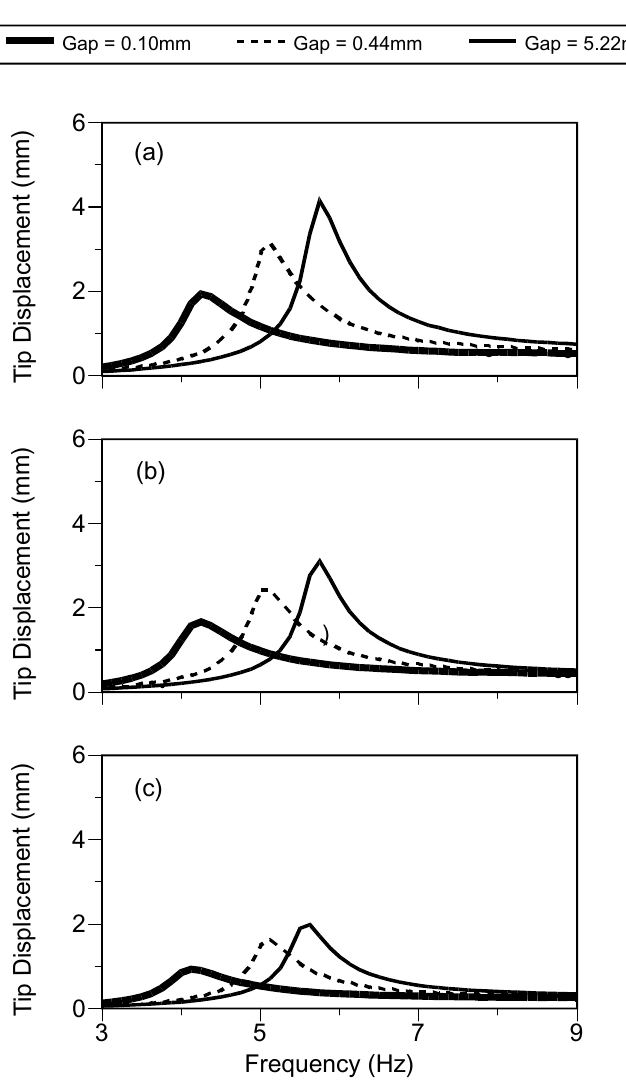
Fig. 9. Frequency response of beam tip at different gaps with base magnets and ferromagnetic constraining layers for base displacement: (c) 0.23 mm, (b) 0.17 mm and (c) 0.11